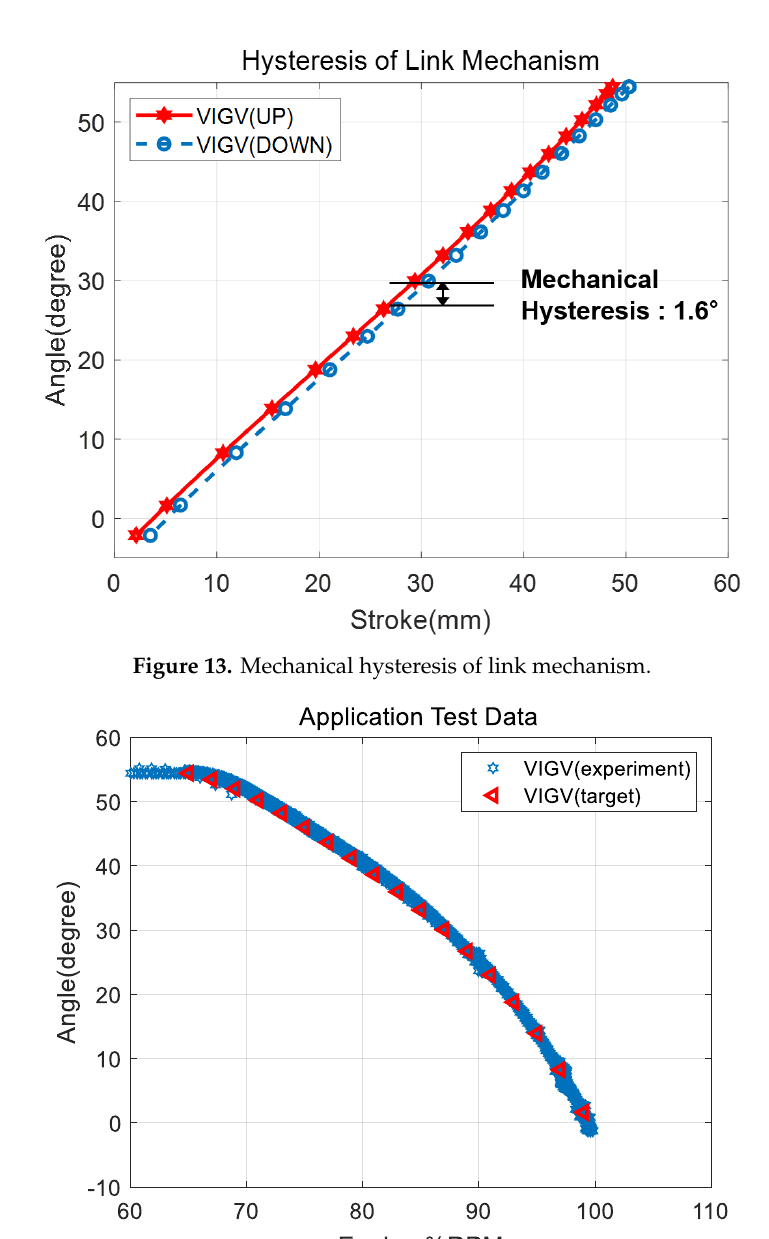
Table 5. VIGV angular errors obtained from the engine application test (unit: